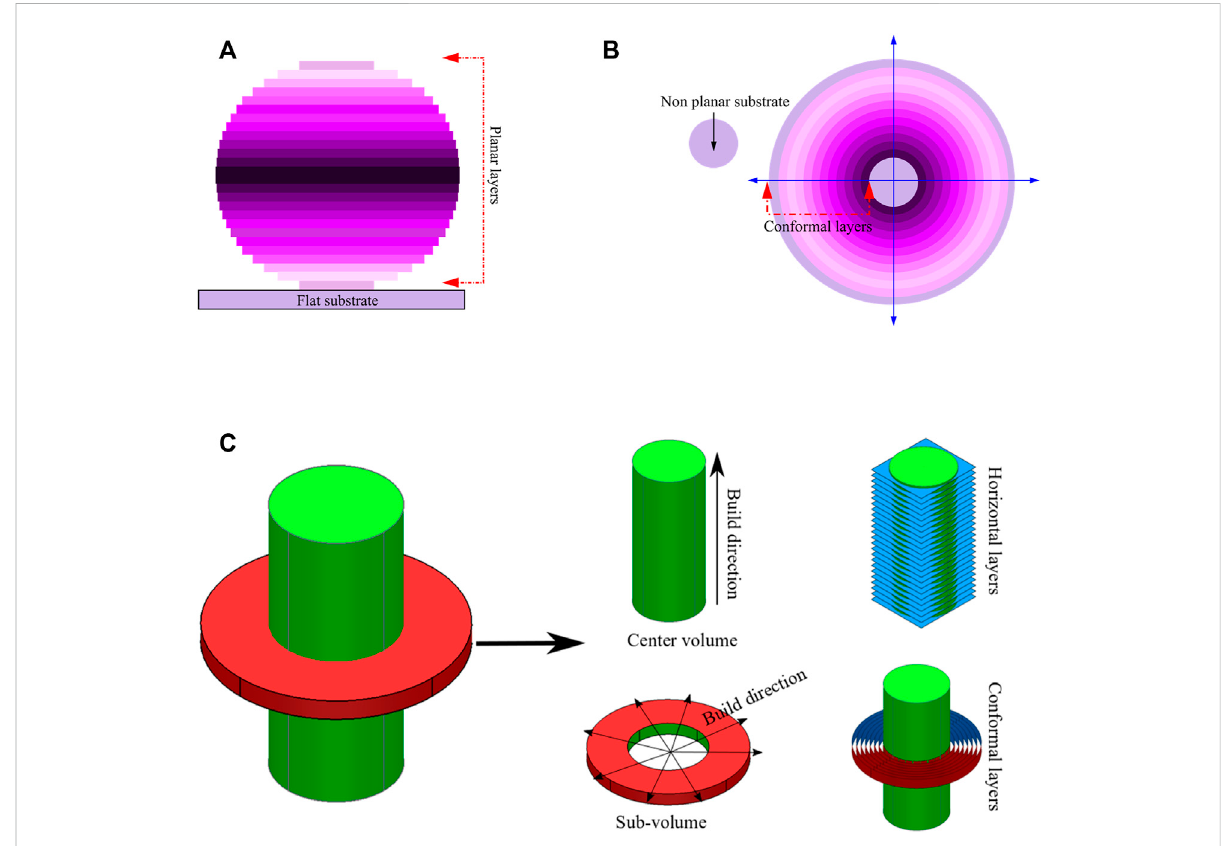
FIGURE 12 Layering strategies based on the geometry of the object (A) Horizontal, (B) Conformal, and (C) horizontal-conformal slicing.